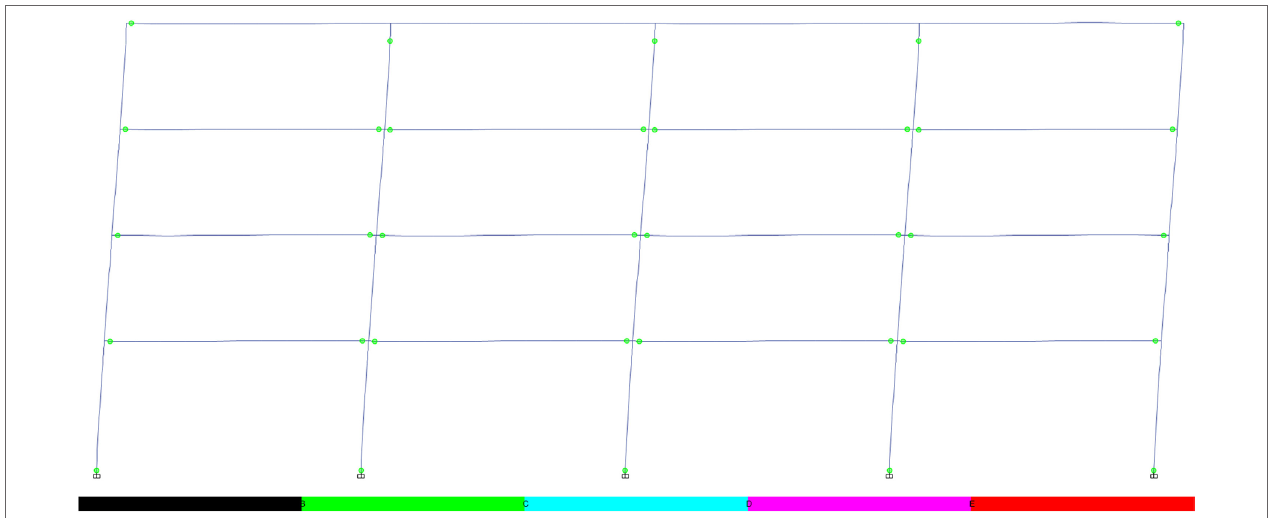
Figure 19 | Plastic hinge formation in reduced web section 4-storey frame (for cross sections, see Figure 5 and Table 2